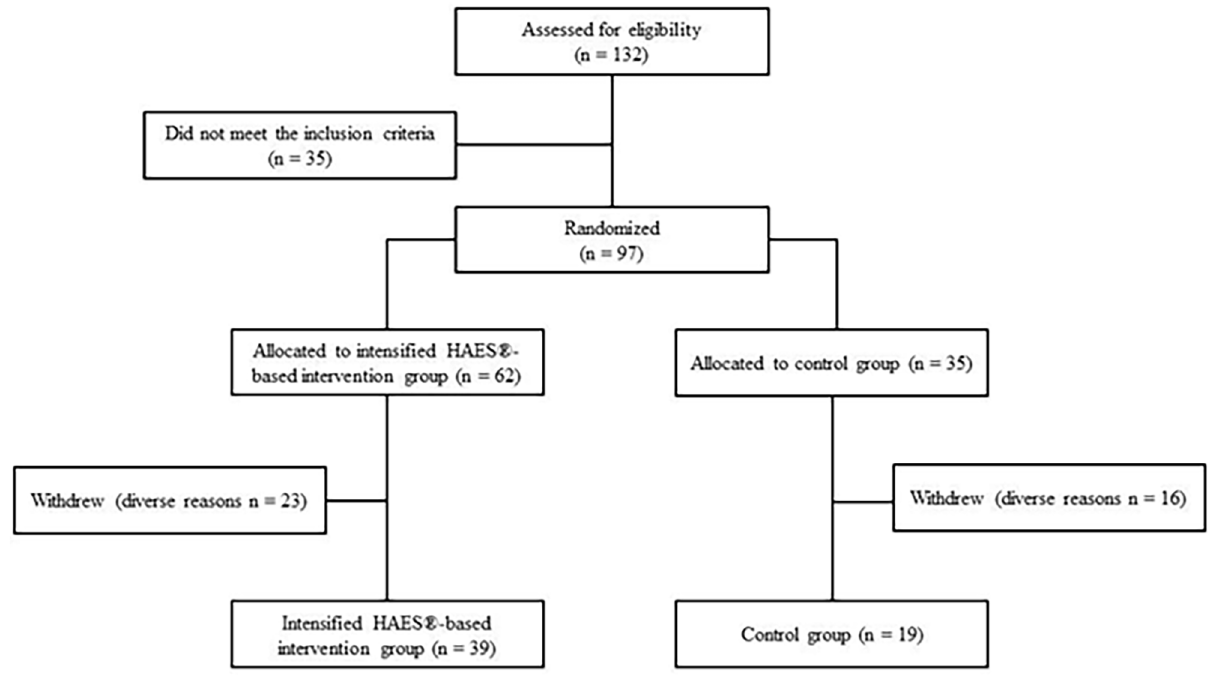
Fig 1. The “Health and Wellness in Obesity” study